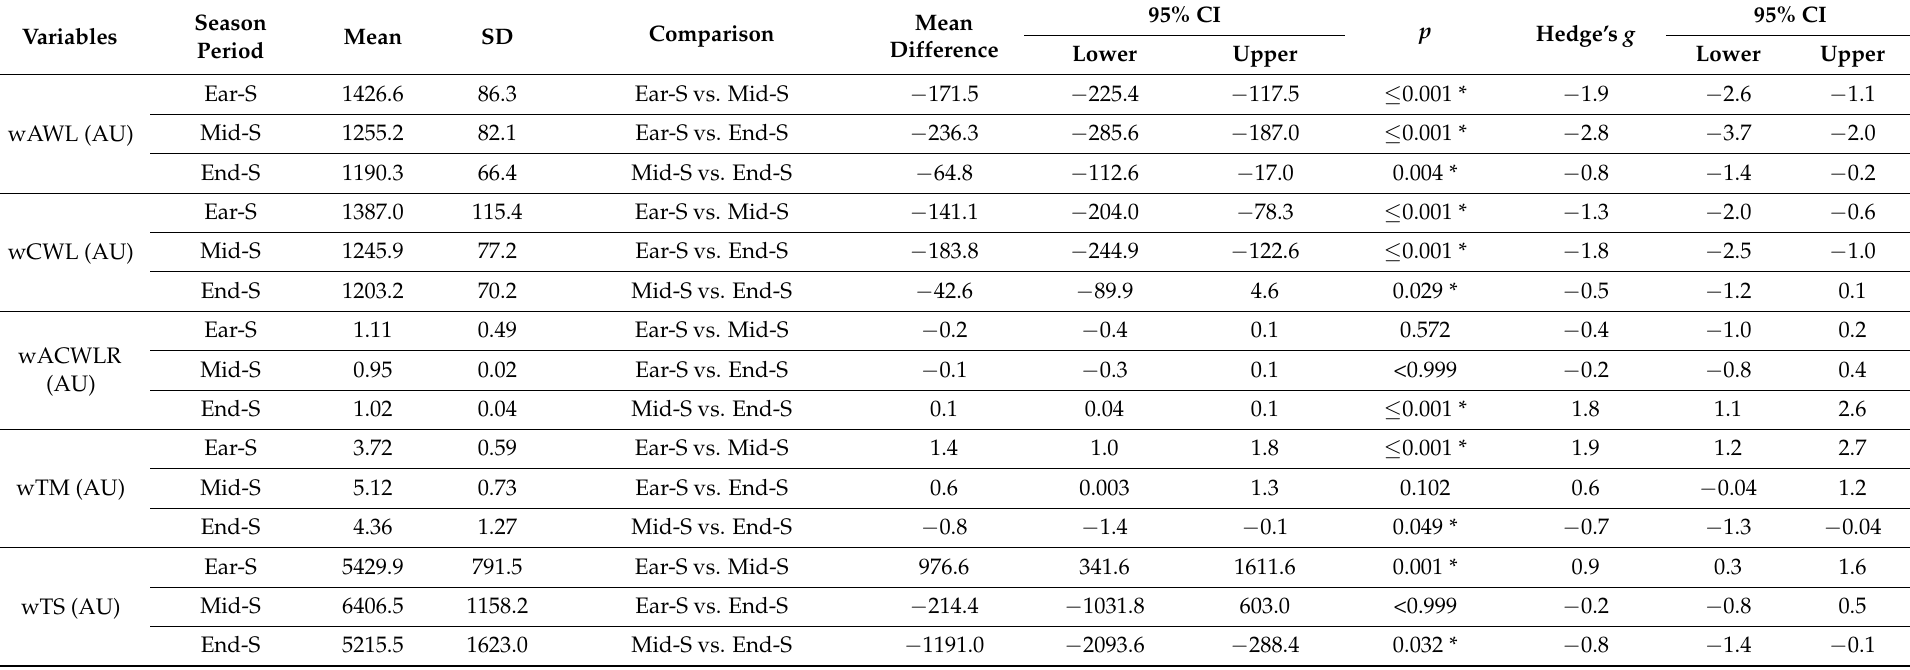
Table 3. Based on training load variables, a comparison among periods of competition season is